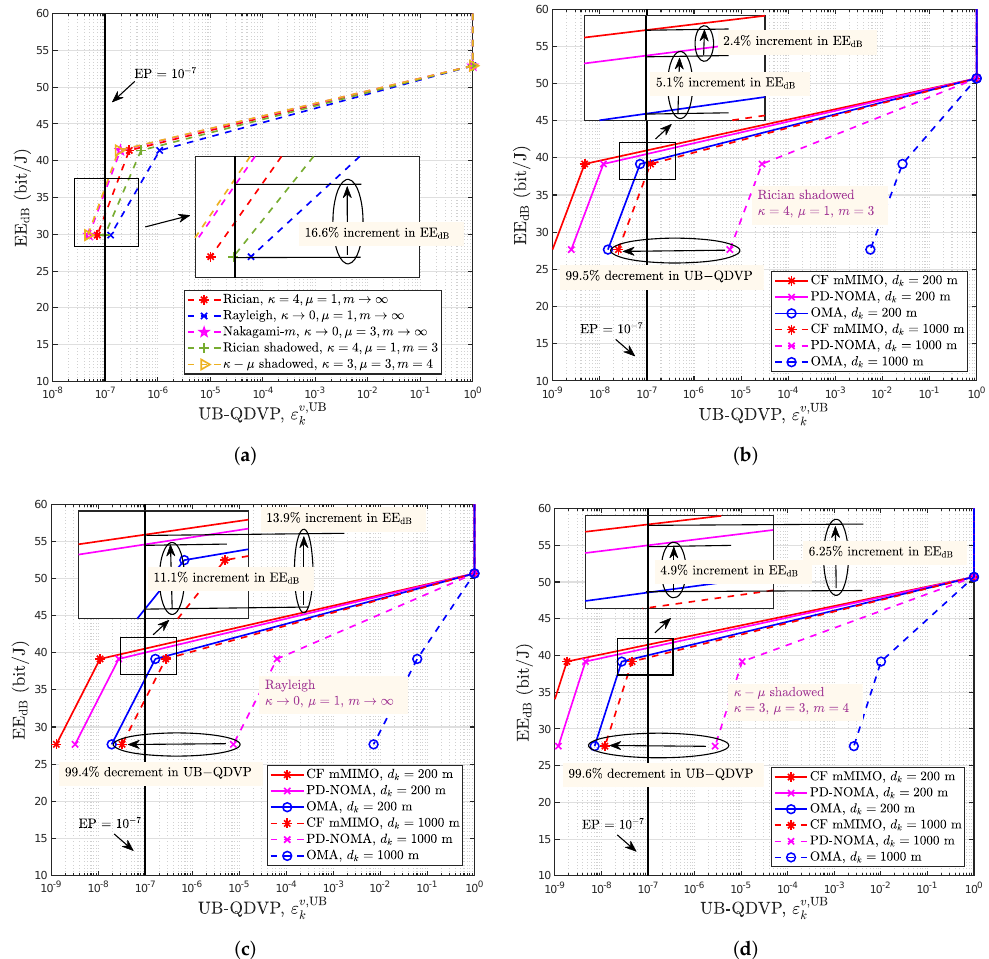
Figure 7. The UB-QDVP vs. EE dB under the κ – µ shadowed fading model. ( a ) Comparison of different small-scale fading types; ( b ) Comparison of different communication systems under Rician shadowed fading; ( c ) Comparison of different communication systems under Rayleigh fading. ( d ) Comparison of different communication systems under κ – µ shadowed fading. Figure 7b–d compare the EE dB and UB-QDVP values obtained under different dis- tances from the user to the center of the coverage area (200 m or 1000 m) in three commu- nications systems under Rician shadowed fading ( κ = 4, µ = 1, m = 3), Rayleigh fading ( κ → 0, µ = 1, m → ∞ ) and κ – µ shadowed fading ( κ = 3, µ = 3, m = 4) when the